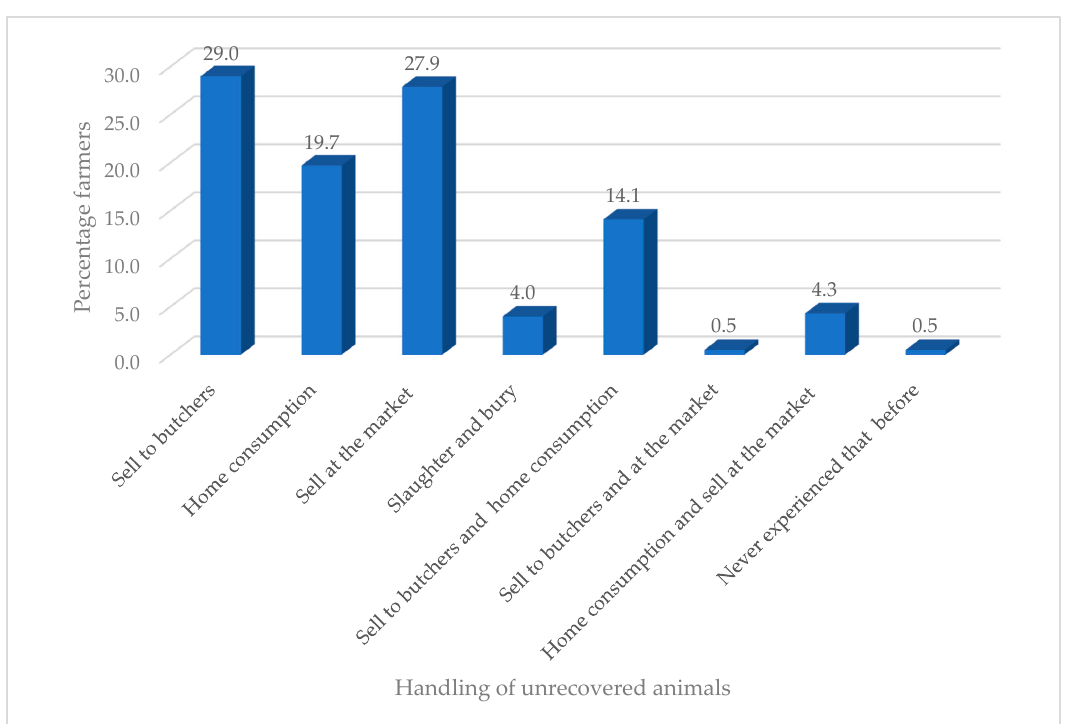
Figure 2. Handling of unrecovered animals.